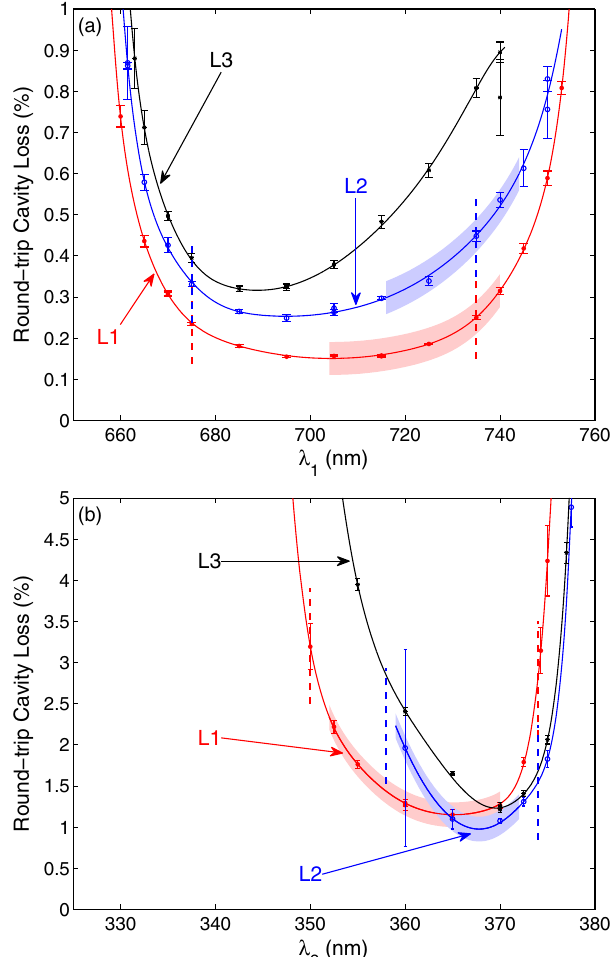
FIG. 2. Measured round-trip cavity losses around the high- reflectivity bands in the (a) IR and (b) UV regions of the FEL mirrors over a 25-month period. Loss curves L1 present the cavity losses after initial conditioning of the FEL mirrors. Loss curves L2 and L3 show the continued degradation of the mirrors ’ reflectivity after they have been exposed to substantial accumulated radiation, estimated to be 9.1 and 11.2 ampere-hours respectively with electron beam energy between 280 and 560 MeV. The ranges enclosed by the dashed lines represent the ranges of single wavelength tuning, and the shaded regions on the curves represent the tuning ranges of the harmonic lasing. (see Sec.